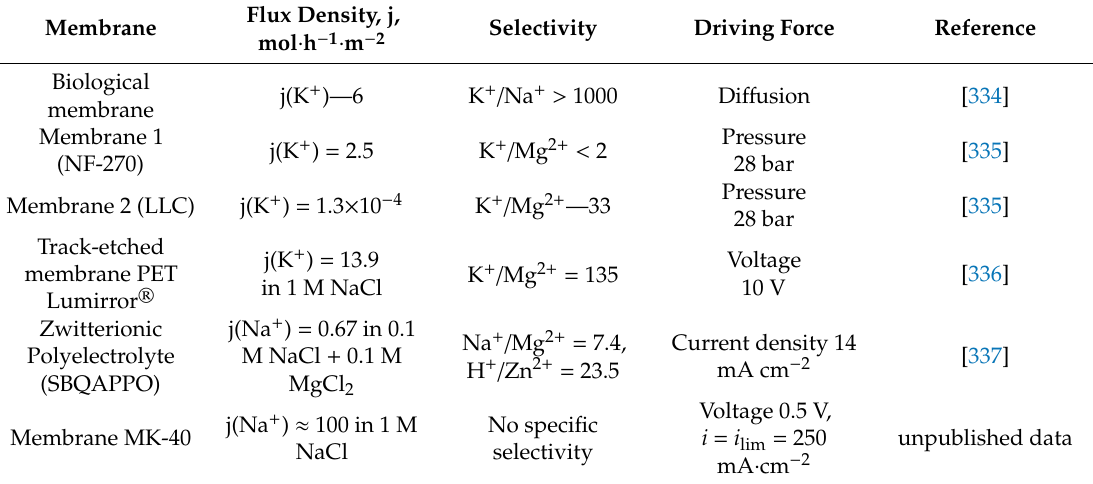
Table 3. The estimations of the specific permselectivity and ionic flux densities for various membranes.